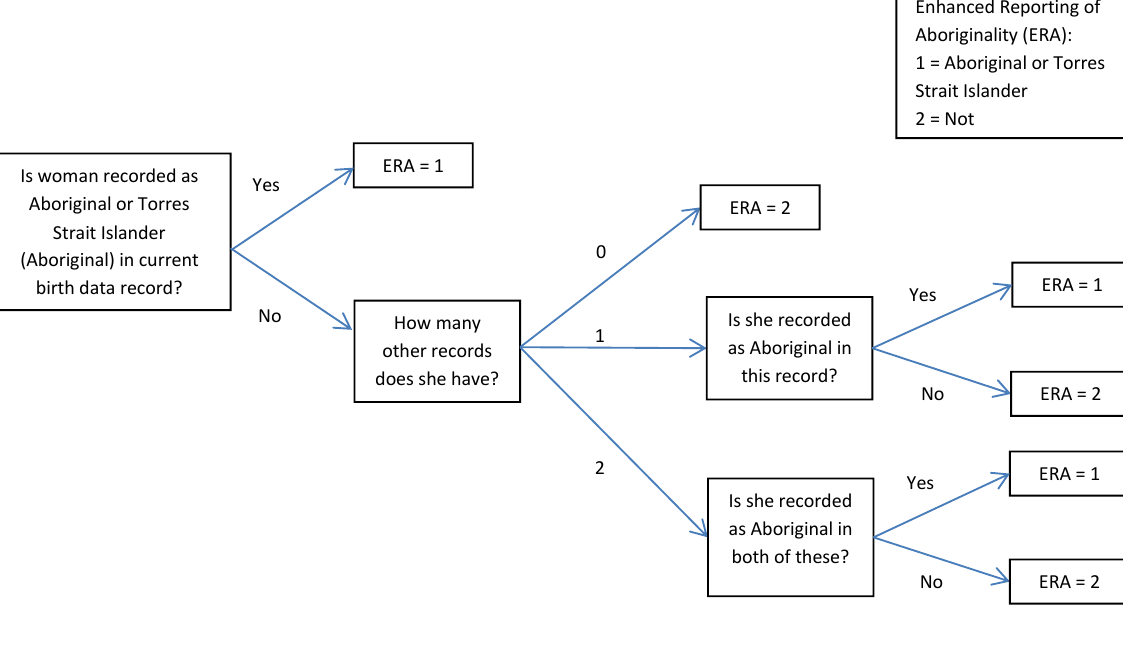
Figure 1: A flow diagram demonstrating the logic used to enhance the reporting of Aboriginality and define study population